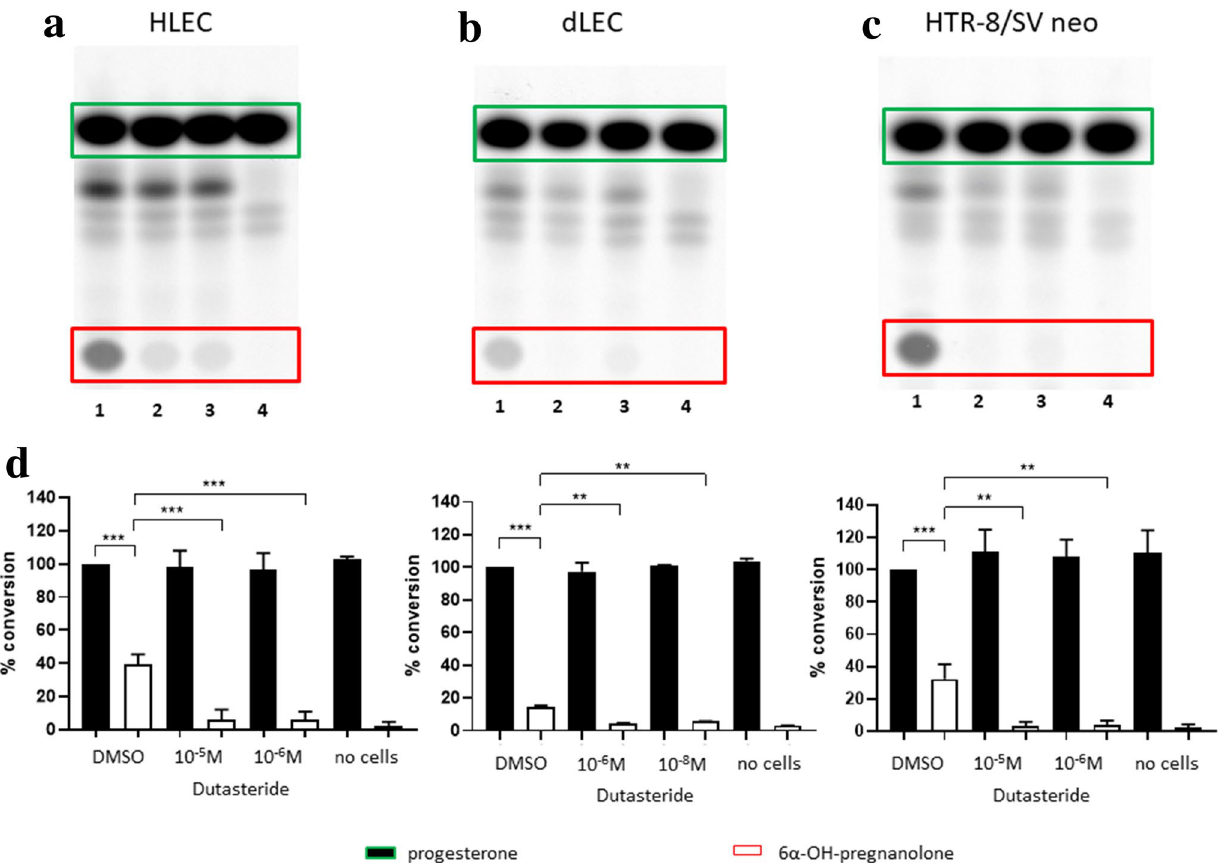
Figure 5. Inhibitory effect of dutasteride on 5α-reductase (SRD5A1-3) in HLECs, dLECs and HTR-8/SV neo. Characteristic phorphorimager pictures of ( a ) HLEC, ( b ) dLEC, ( c ) HTR-8/SV neo and their densitometry ( d ) of three independent experiments. Cells were cultured without (lane 1) and with (lane 2 and 3) the indicated concentration of dutasteride and 14C-progesterone. Lane 4 is the cell-free control, where 14C-progesterone was incubated for 24 h without cells. HLEC and HTR-8/SV neo: (1) no dutasteride = DMSO control, (2) dutasteride 10−5 M, (3) dutasteride 10−6 M, (4) no cells; dLEC: (1) no dutasteride, (2) dutasteride 10−6 M, (3) dutasteride 10−8 M, (4) no cells. Progesterone was significantly metabolized to 6α-OH-pregnanolone in the DMSO control, while dutasteride significantly inhibited the conversion of progesterone to 6α-OH-pregnanolone in all three cell lines. Data were normalized to condition 0 h = 100% progesterone. One-way ANOVA, Dunnett’s multiple comparisons test, n = 3. HLEC: DMSO control *** p < 0.0001; dutasteride 10−5 M *** p < 0.0001; dutasteride 10−6 M *** p < 0.0001. dLEC: DMSO control *** p < 0.0001; dutasteride 10−6 M ** p = 0.0001; dutasteride 10−8 M ** p = 0.0006. HTR-8/SV neo: DMSO control *** p < 0.0001; dutasteride 10−5 M ** p = 0.0005; dutasteride 10−6 M ** p = 0.0006. Green rectangle/black column: substrate (progesterone). Red rectangle/white column: product (6α-OH-pregnanolone). * p < 0.05, ** p < 0.01, *** p < 0.0001, ns = not